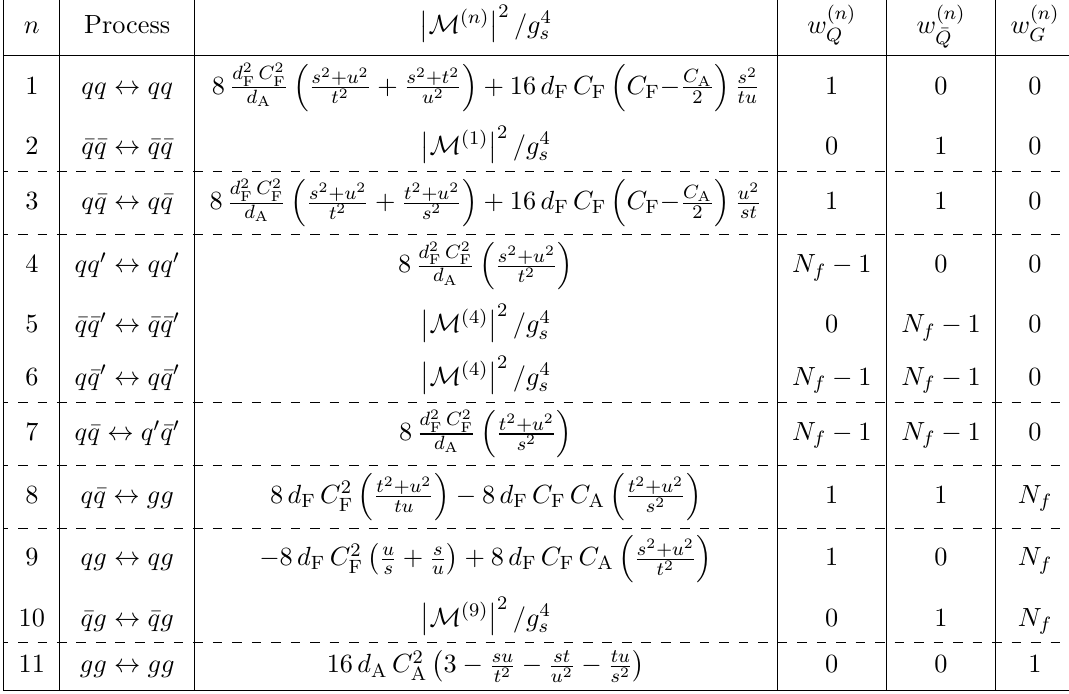
Table 1 . List of the binary collision processes that can produce a hard parton in the (cid:12)nal state with large transverse momentum with respect to the incoming probe. Here, q and q 0 are quarks of distinct (cid:13)avors, (cid:22) q and (cid:22) q 0 the associated antiquarks, and g is a gauge boson (gluon). The third column lists explicit leading order expressions for the corresponding QCD squared matrix elements, in vacuum, summed over initial and (cid:12)nal polarizations and colors, as a function of the standard Mandelstam variables t = (cid:0) 2 ( p 0 p (cid:0) p 0 (cid:1) p ), u = (cid:0) 2 ( p 0 k (cid:0) p 0 (cid:1) k ) and s = (cid:0) t (cid:0) u . (See ref. [62].) In a SU( N c ) theory with fermions in the fundamental representation, we have for the dimensions (cid:0) (cid:1) of the representations and the Casimir factors d F = C A = N c , C F = N 2 (cid:0) 1 = (2 N c ), and d A = c 2 d F C F = N 2 (cid:0) 1. For SU(3) (i.e. QCD), d F = C A = 3, C F = 4 = 3, and d A = 8. Finally, we give the c degeneracy factors w ( n ) appearing in eq. (2.13). Here, N f is the number of light (cid:13)avors; we take C N f = 3